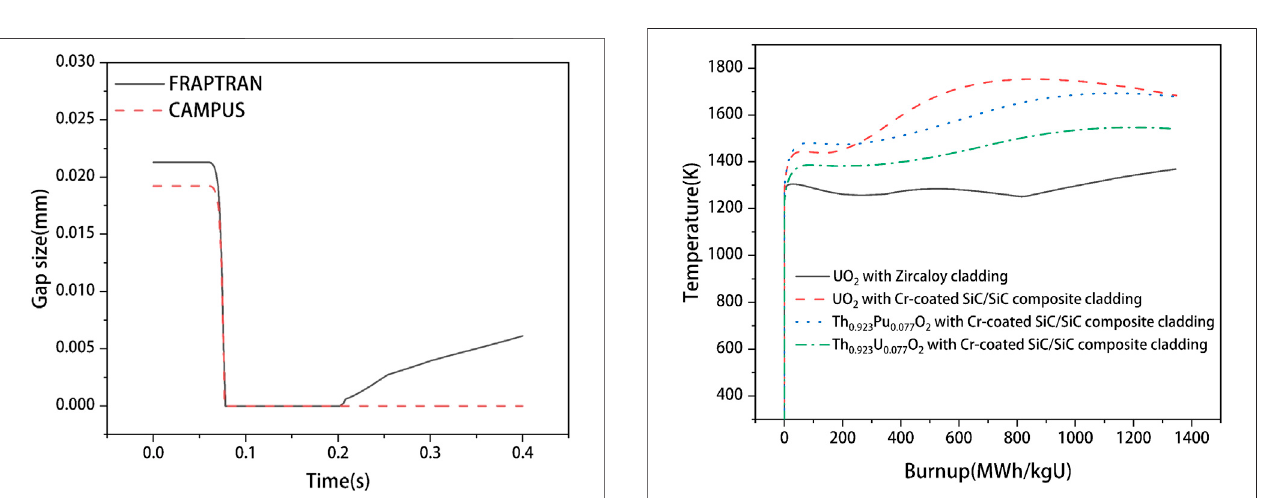
FIGURE11| Fuelcenterlinetemperature evolutionsfortheUO 2 fuelwith Zircaloy cladding, the Th 0.923 Pu 0.077 O 2 fuel, and Th 0.923 U 0.077 O 2 fuel with Cr- coated SiC/SiC composite cladding under the normal operating